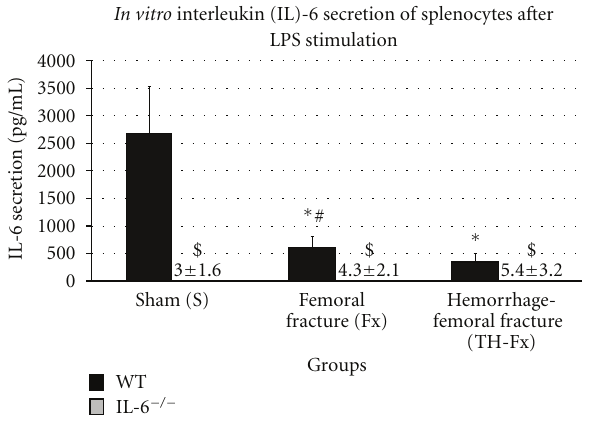
Figure 3: IL-10 productive capacity of splenocytes in response to their stimulation with LPS in wild-type (WT) and IL-6 knockout (IL-6 − / − ) mice in sham animals (group S), after an isolated femoral fracture (group Fx) and after the combination of a femoral fracture and hemorrhage (group TH-Fx). ∗ stat. significance ( P < 0 . 05) S versus. Fx and TH-Fx, $ stat. significance ( P < 0 . 05) WT versus. IL-6 − / −